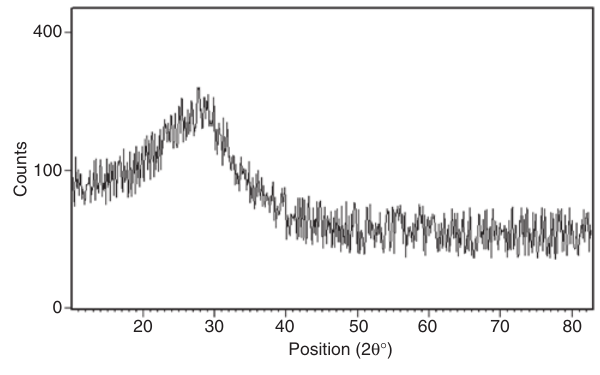
Figure 3: XRD pattern of nano-basic silica.